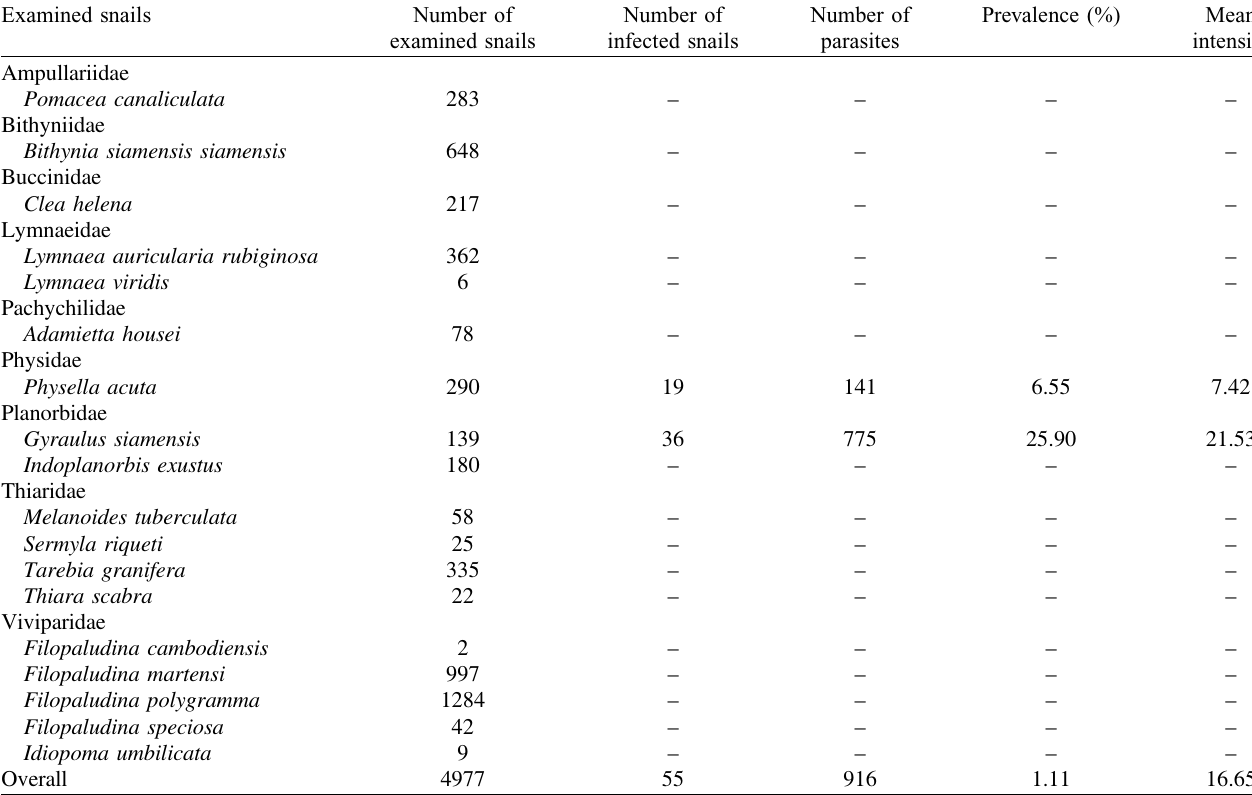
Table 2. Species and number of examined gastropods collected from Bangkok with their infective